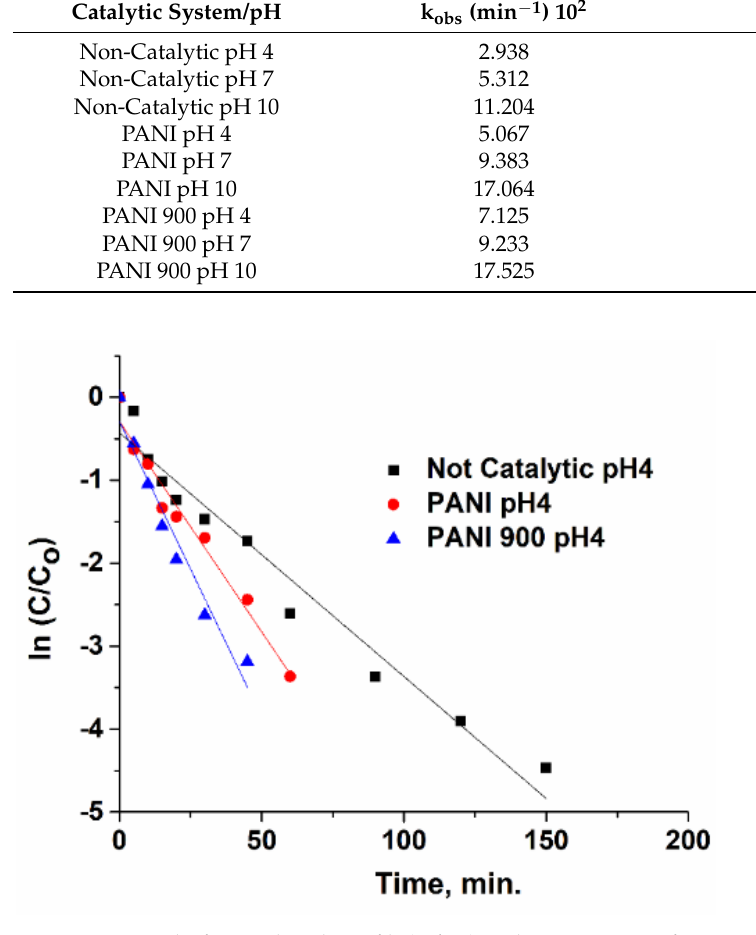
Figure 18. Pseudo-first-order plots of ln(C/C o ) with reaction time for pH Figure 18. Pseudo – first – order plots of ln(C/C o ) with reaction time for pH 4.